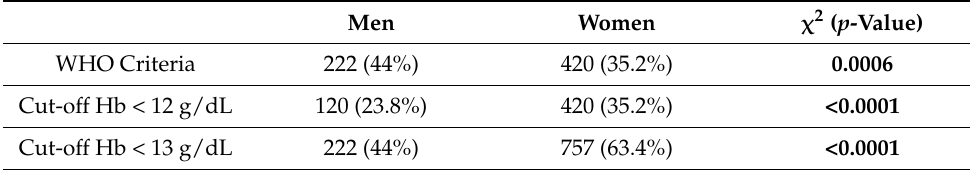
Table 5. Prevalence of anemia according to different cut-off levels. Men WHO Criteria 222 (44%)